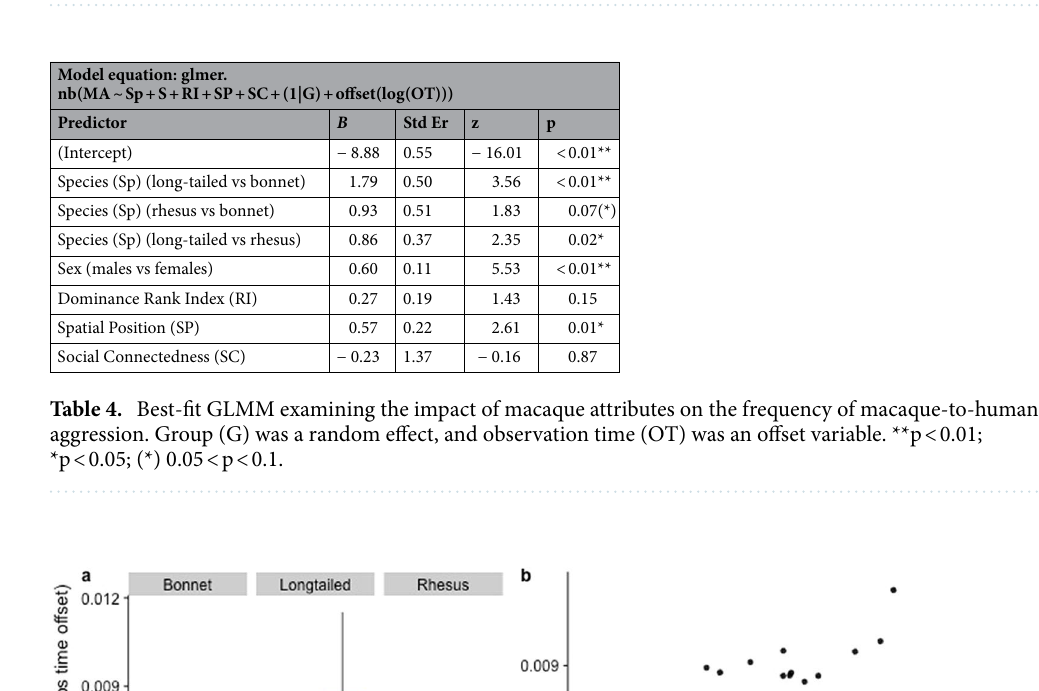
Figure 5. Effect of sex, species and spatial position on the complexity of human–macaque interactions. Figure was created using R (Version 3.6.1: https ://www.r-proje ct.org/).